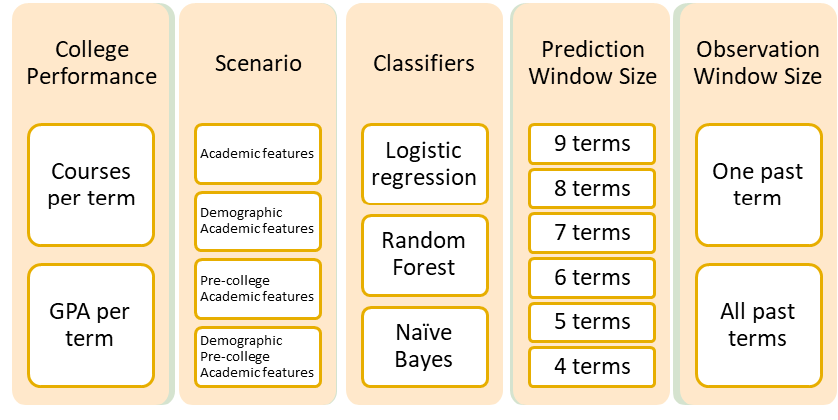
Figure 4. Experiments